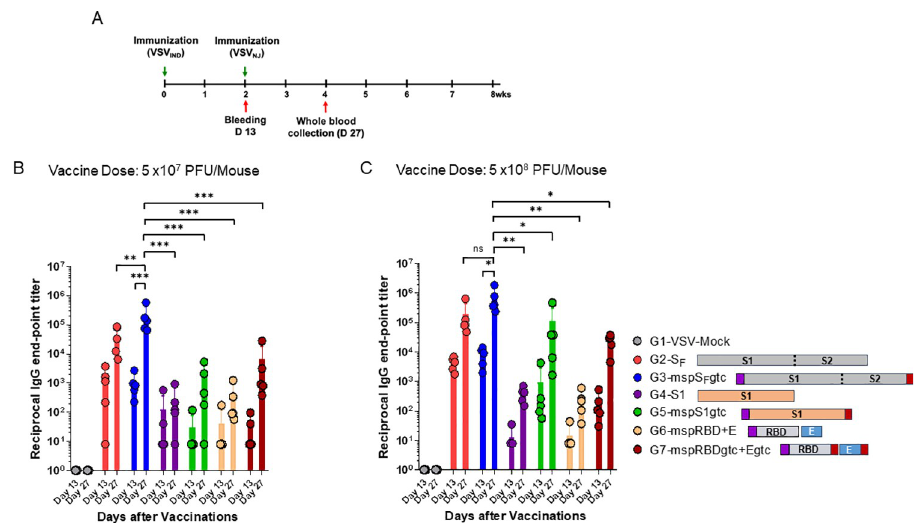
Fig 5. Full-length S F protein with the melittin signal peptide (msp) at the amino terminus and VSV G protein transmembrane domain and cytoplasmic tail (Gtc) at the carboxyl terminus induce the highest IgG titers against the SARS-CoV-2 Spike( Δ TM) protein. Mice were prime immunized with rVSV Ind -SARS-CoV-2 and boost immunized with rVSV NJ -SARS-CoV-2 two weeks after prime-immunization. Serum was collected to determine SARS- CoV-2 S1 protein-specific antibody levels by ELISA on day 13, one day before boost-immunization, and on day 27, two weeks after boost-immunization. (A) Prime-boost vaccination schedule. (B) Spike( Δ TM)-specific IgG titer after the prime-boost vaccination with doses of 5X10 7 PFU/mouse ( C) Spike( Δ TM)-specific IgG titer after the prime-boost vaccination with doses of 5X10 8 PFU/mouse. Statistical significance was determined by two-way ANOVA with Tukey’s correction ( � , p < 0.05; �� , p < 0.005; ��� , p < 0.001; ns, not significant). The data were presented as means with error bars of standard deviation (n = 5 mice per group). Purple box: honeybee msp, red box: VSV Gtc. VSV-Mock denotes VSV vector alone without any gene insert.